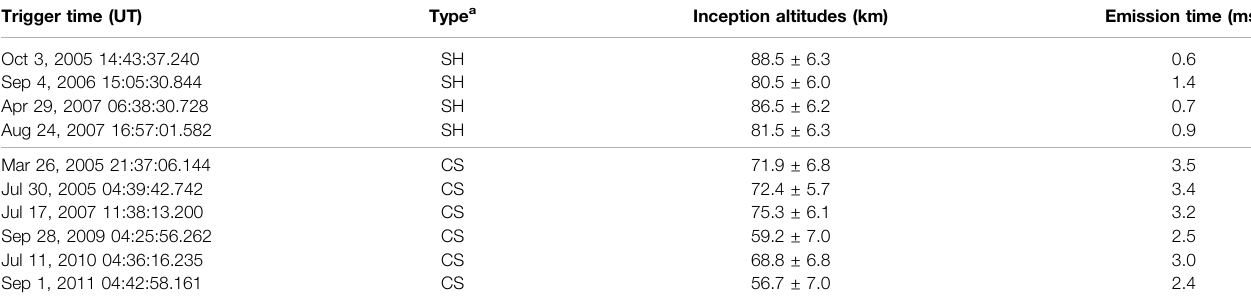
TABLE 1 | The event list for two sprite categories (sprite halo and carrot sprite events) and their inception altitudes and emission times. Trigger time